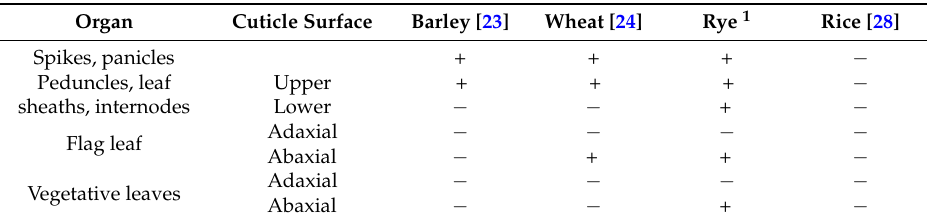
Table 3. Location of β -diketone aliphatics.